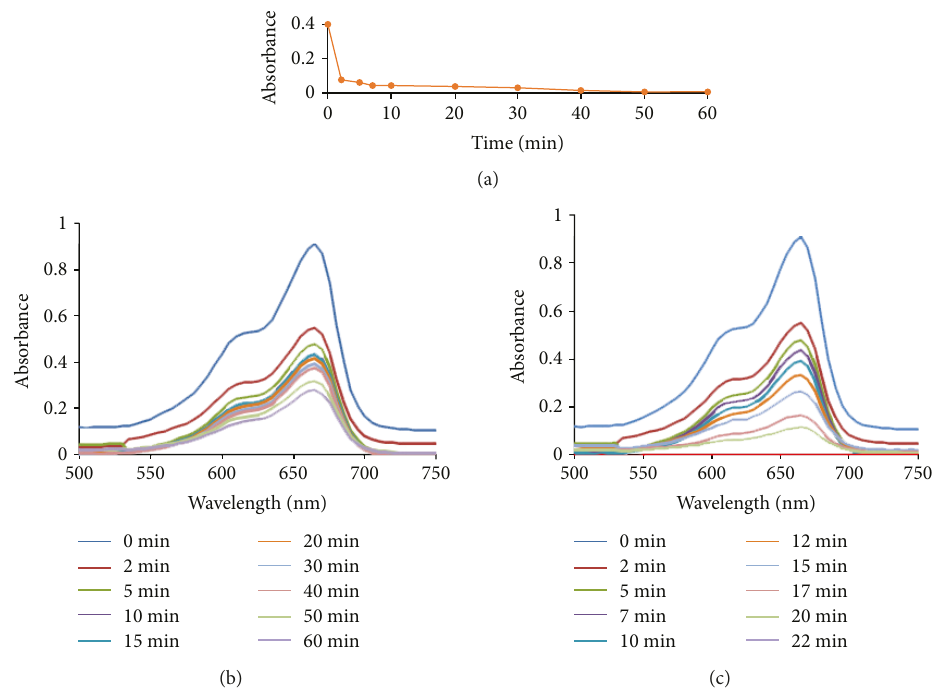
Figure 4: UV-Vis absorption spectra recorded for the progress in reduction of MB dye: (a) 2.5mL of MB ( 2 5 × 10 − 5 M ) solution and 2.5mL of fresh Psidium guajava extract, (b) 2.5mL of MB ( 2 5 × 10 − 5 M ) solution and 2.5mL of fresh Psidium guajava extract with 0.25g of CPUF, and (c) 2.5mL of MB ( 2 5 × 10 − 5 M ) solution, Psidium guajava extract, and ascorbic acid (50 :50) with 0.25g of